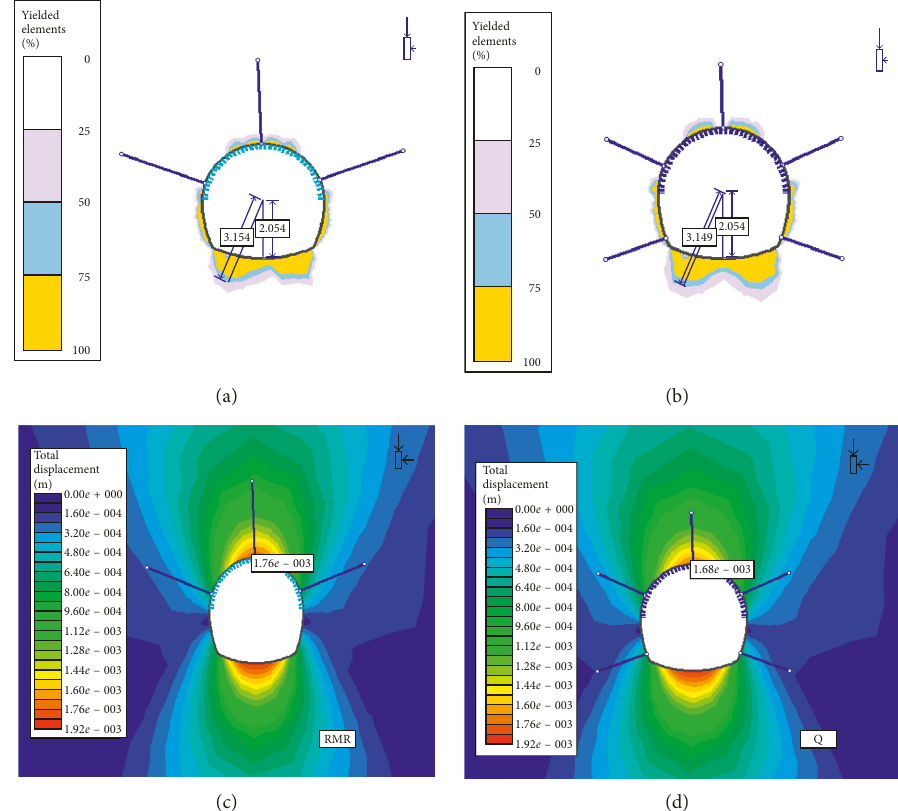
Figure 3: Yield elements and yield zone (50%) after RMR (a) and Q (b) supports. Deformation after RMR (c) and Q (d)